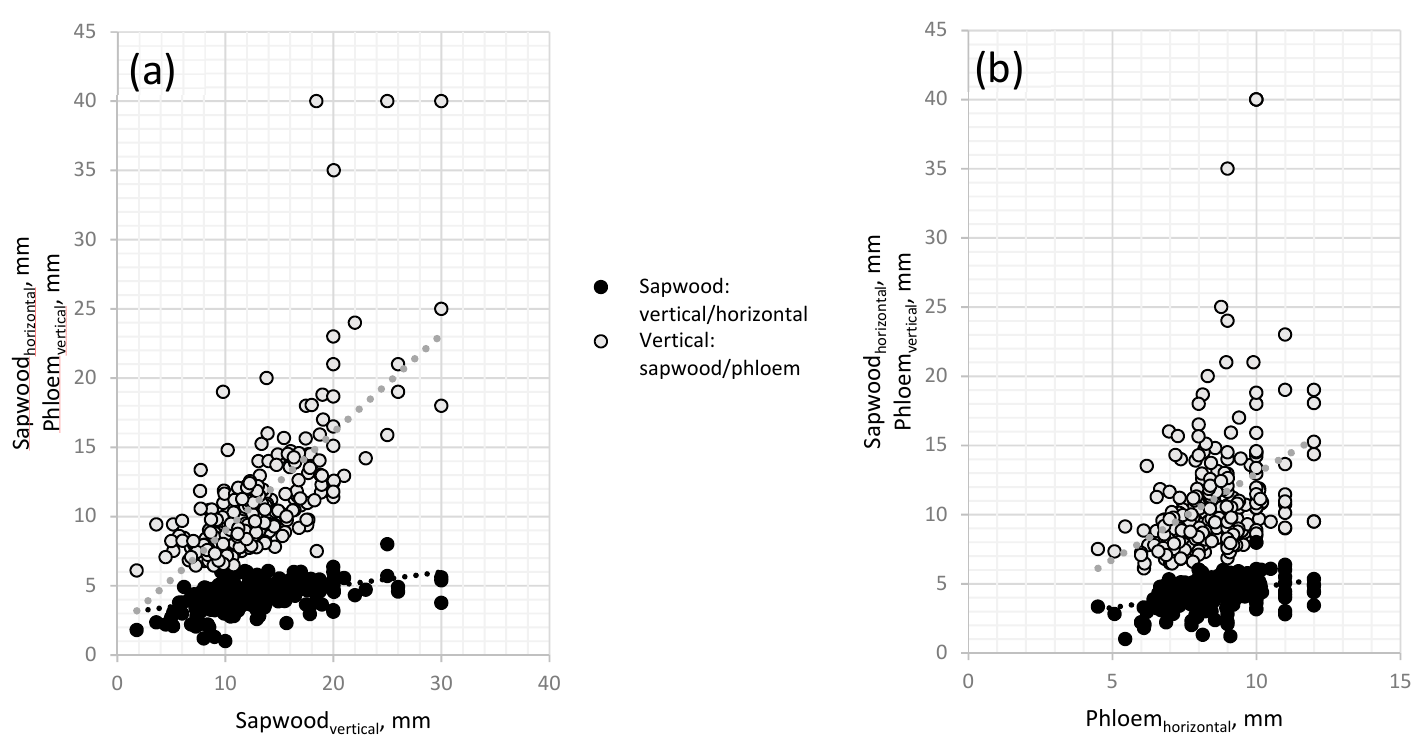
Figure 7. ( a ) Statistically significant ( p < 0.01) positive correlations between vertical and horizontal necrosis length in sapwood (black), and vertical necrosis length between sapwood and phloem (grey); ( b ) Statistically significant ( p < 0.01) positive correlations between vertical and horizontal necrosis length in phloem (grey), and horizontal necrosis length between sapwood and phloem (black). Positive correlations indicate that when one variable increases the other variable simultaneously increases.